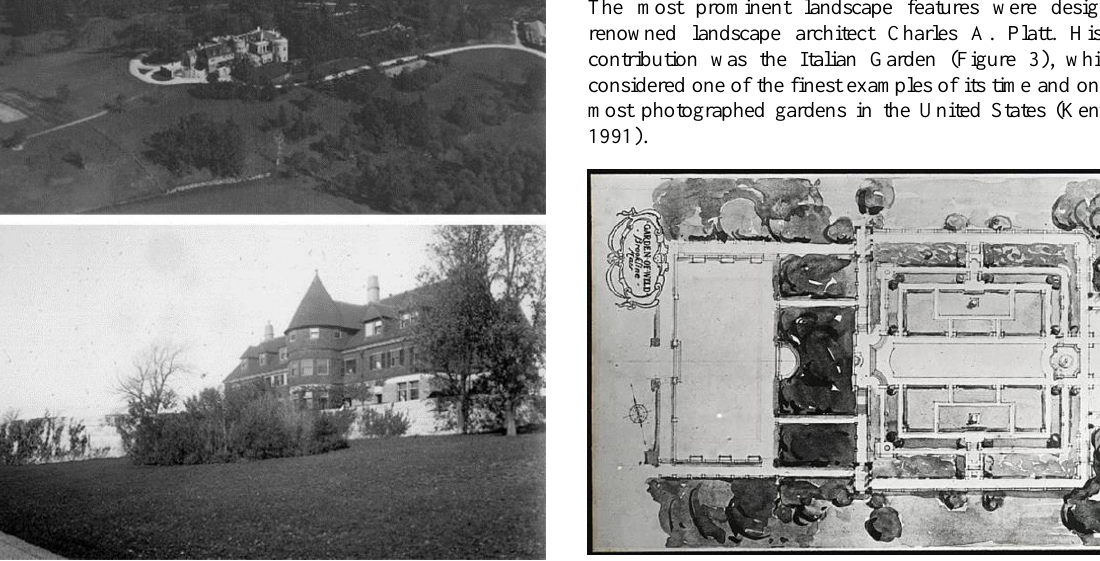
Figure 3. Charles A. Platt plan of Italian garden at Weld, 1915. Source: Library of